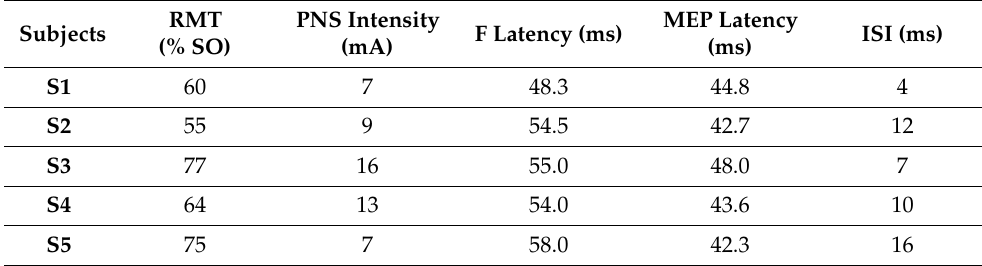
Table 1. Stimulation parameters used for individual subjects.